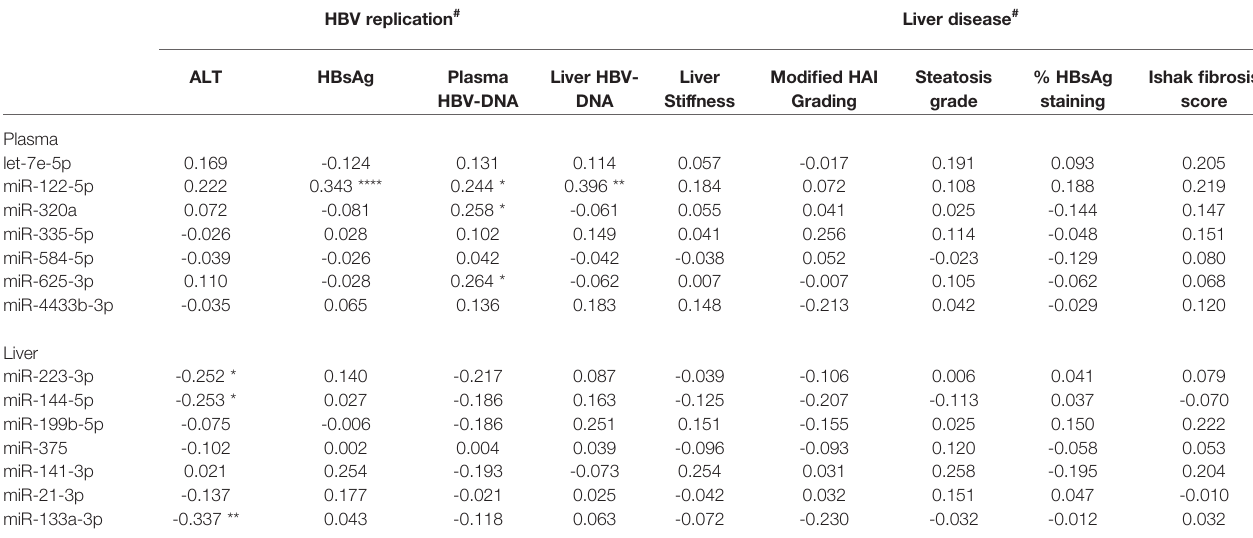
TABLE 4 | The association of plasma and liver miRNAs levels with biomarkers of HBV replication and liver